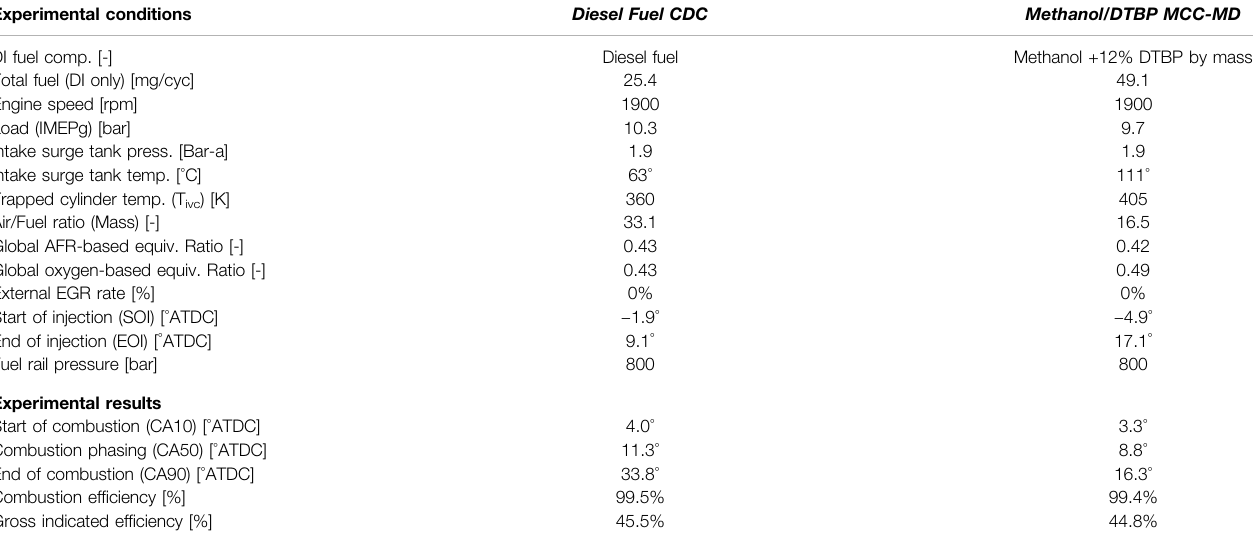
TABLE 3 | Experimental operating conditions for single-cylinder GM 1.9 L